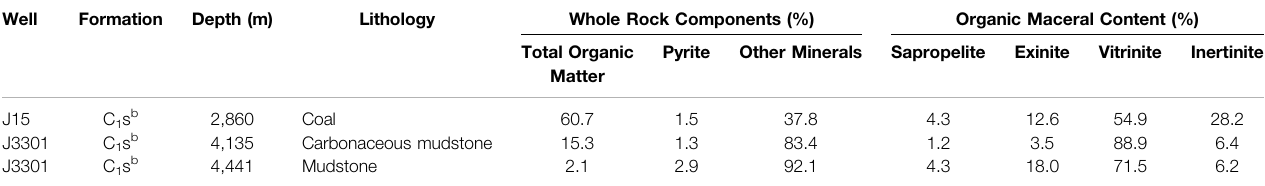
TABLE 1 | The maceral characteristics of C 1 s b source rocks in the Jimsar